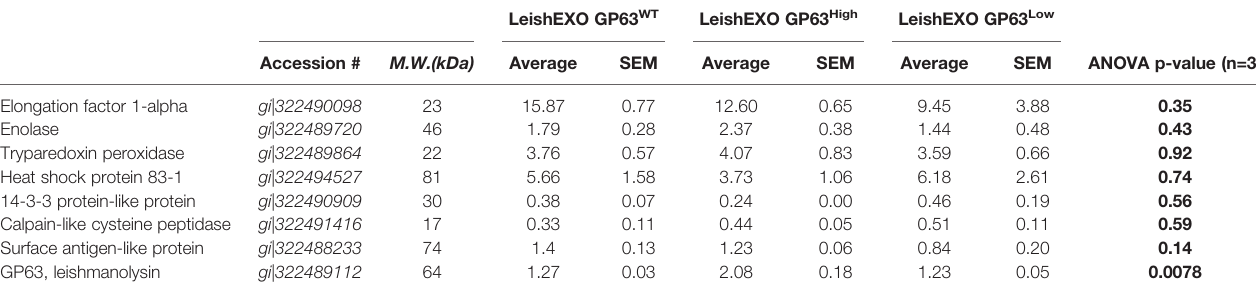
TABLE 3 | GP63 expression change did not alter the levels of other known Leishmania spp. virulence factors on Leishmania amazonensis- derived EVs.